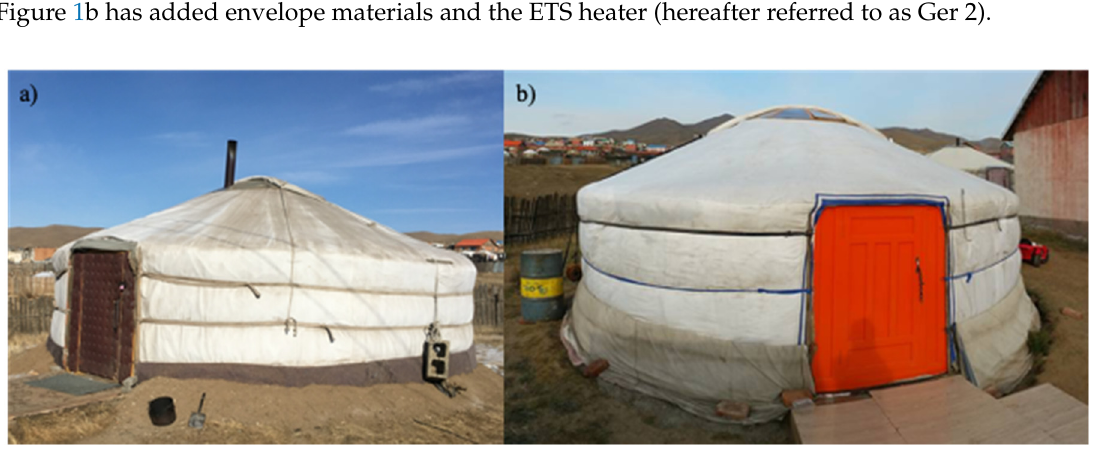
(cid:48) Ger 1 s. Figure 2 shows an electrical diagram of the experimental setup and electrical wiring of the two gers. As shown in Figure 2a, the light, television, refrigerator, and outlet, etc.—the major electrical appliances—of Ger 1 were supplied from the main grid (1), and the total electricity consumption of both gers was measured using a power meter (2) with a three-phase current sensor (3). Voltage (10), current (9), temperature (12), and humidity (11) sensors attached to module loggers for the voltage (4), current (5), humidity (6), and temperature (7) measured the electricity consumption, indoor air temperature, and humidity. Figure 2b shows an electrical diagram of Ger